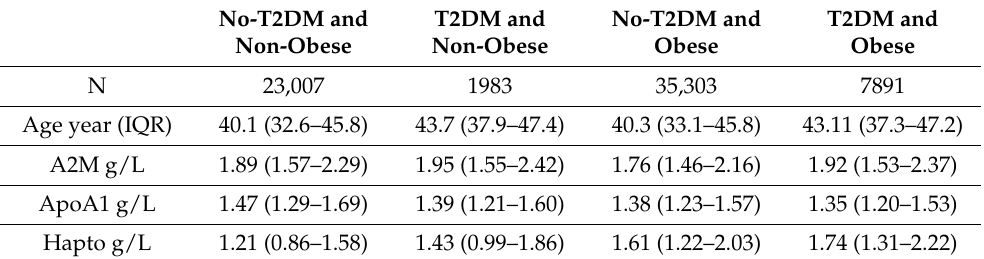
Table 2. Characteristics and median protein levels in women <50 years of age according to T2DM and obese status.